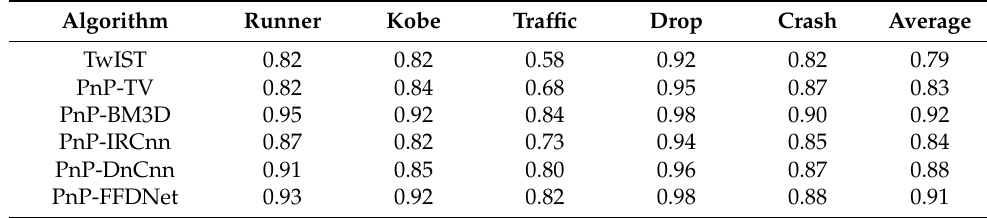
Table 2. The average SSIM